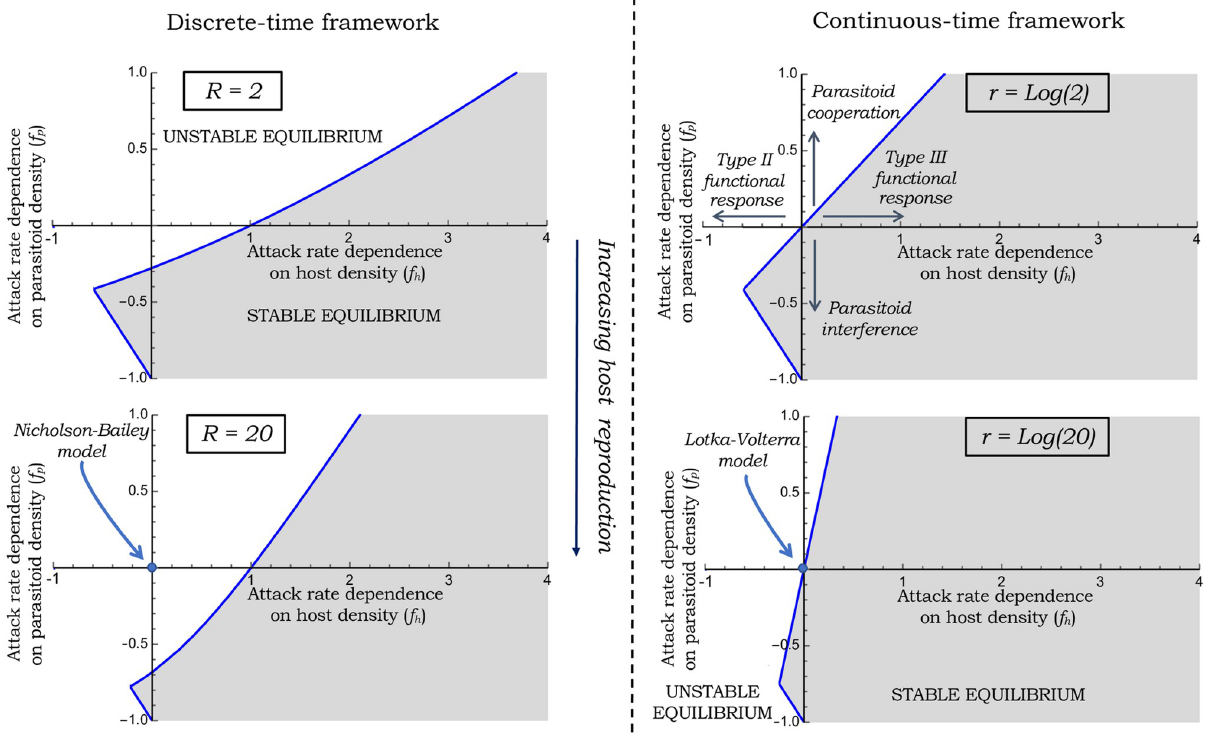
Fig 1. The stability region (grey shaded area) as determined by (5) and (10) in continuous time (right) and discrete-time (left), respectively, is plotted as function of f h (attack-rate sensitivity to the host density) and f p (attack-rate sensitivity to the parasitoid density). The origin f h = f p = 0 represents the classical Lotka-Volterra and Nicholson-Bailey models. While the former model in continuous time is on the edge of stability indicating a neutrally-stable equilibrium, the Nicholson-Bailey model in discrete time is outside the grey shaded area indicating an unstable equilibrium. The stability regions are plotted for two different levels of host reproduction— R = 2 (top) and R = 20 (bottom) with r = log R and γ = 1.